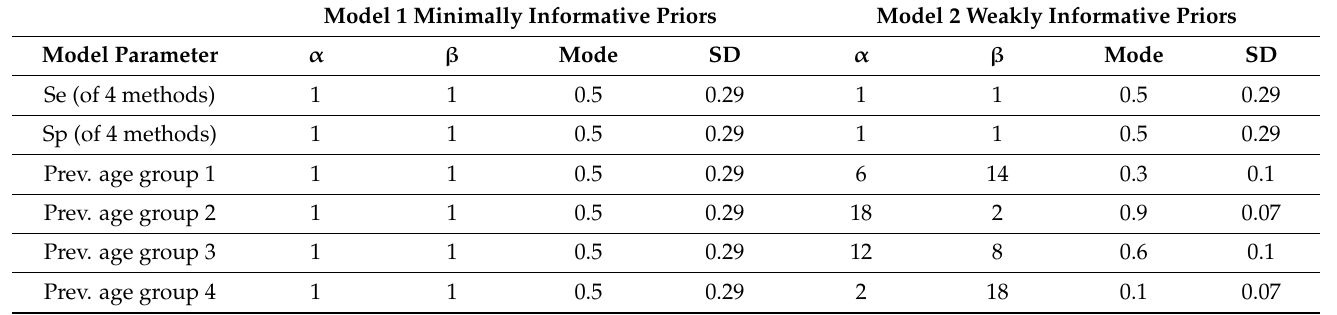
Table 1. Priors used in Bayesian LCA (latent class analysis), with α and β as parameters for the beta distribution (Se = sensitivity, Sp = specificity, Prev. = prevalence, SD = standard